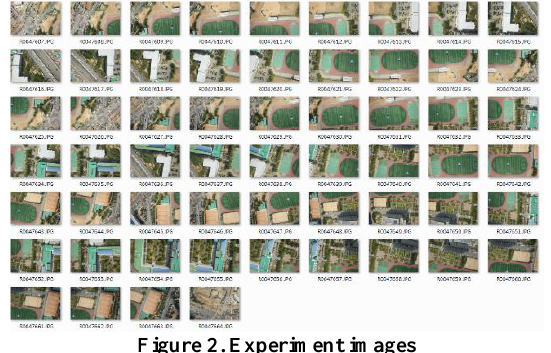
Figure 2. Experiment images Table 1. Properties of UAV images (interior orientation